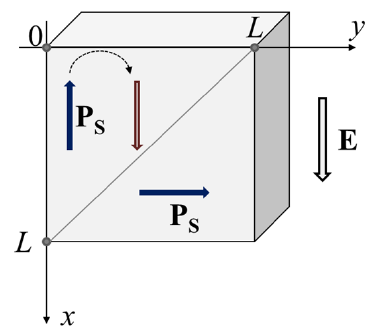
Figure 2. The diagram of polarization switching in c-domains of a BaTiO 3 ferroelectric